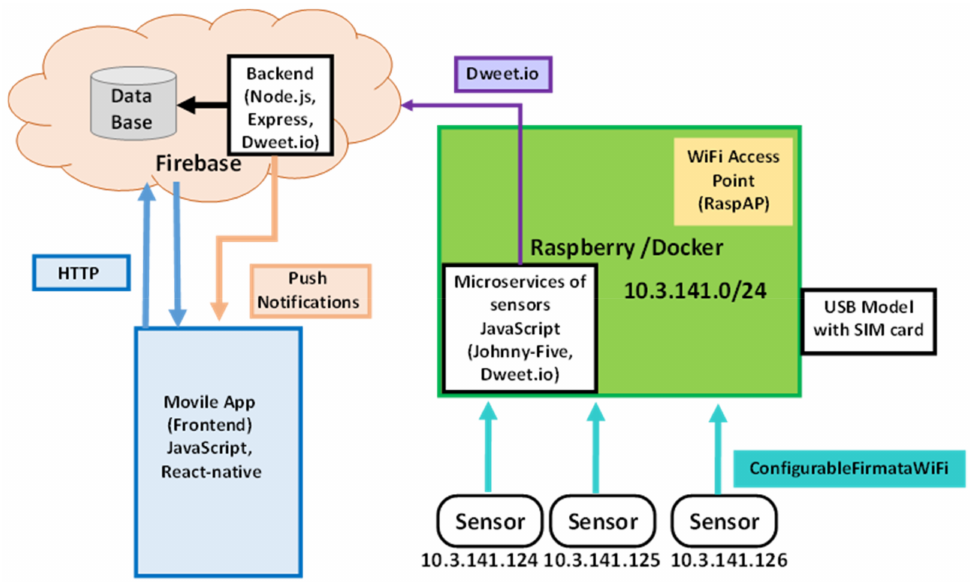
Figure 8. Network architecture for mobile communication between the microservices for sensors and the cloud